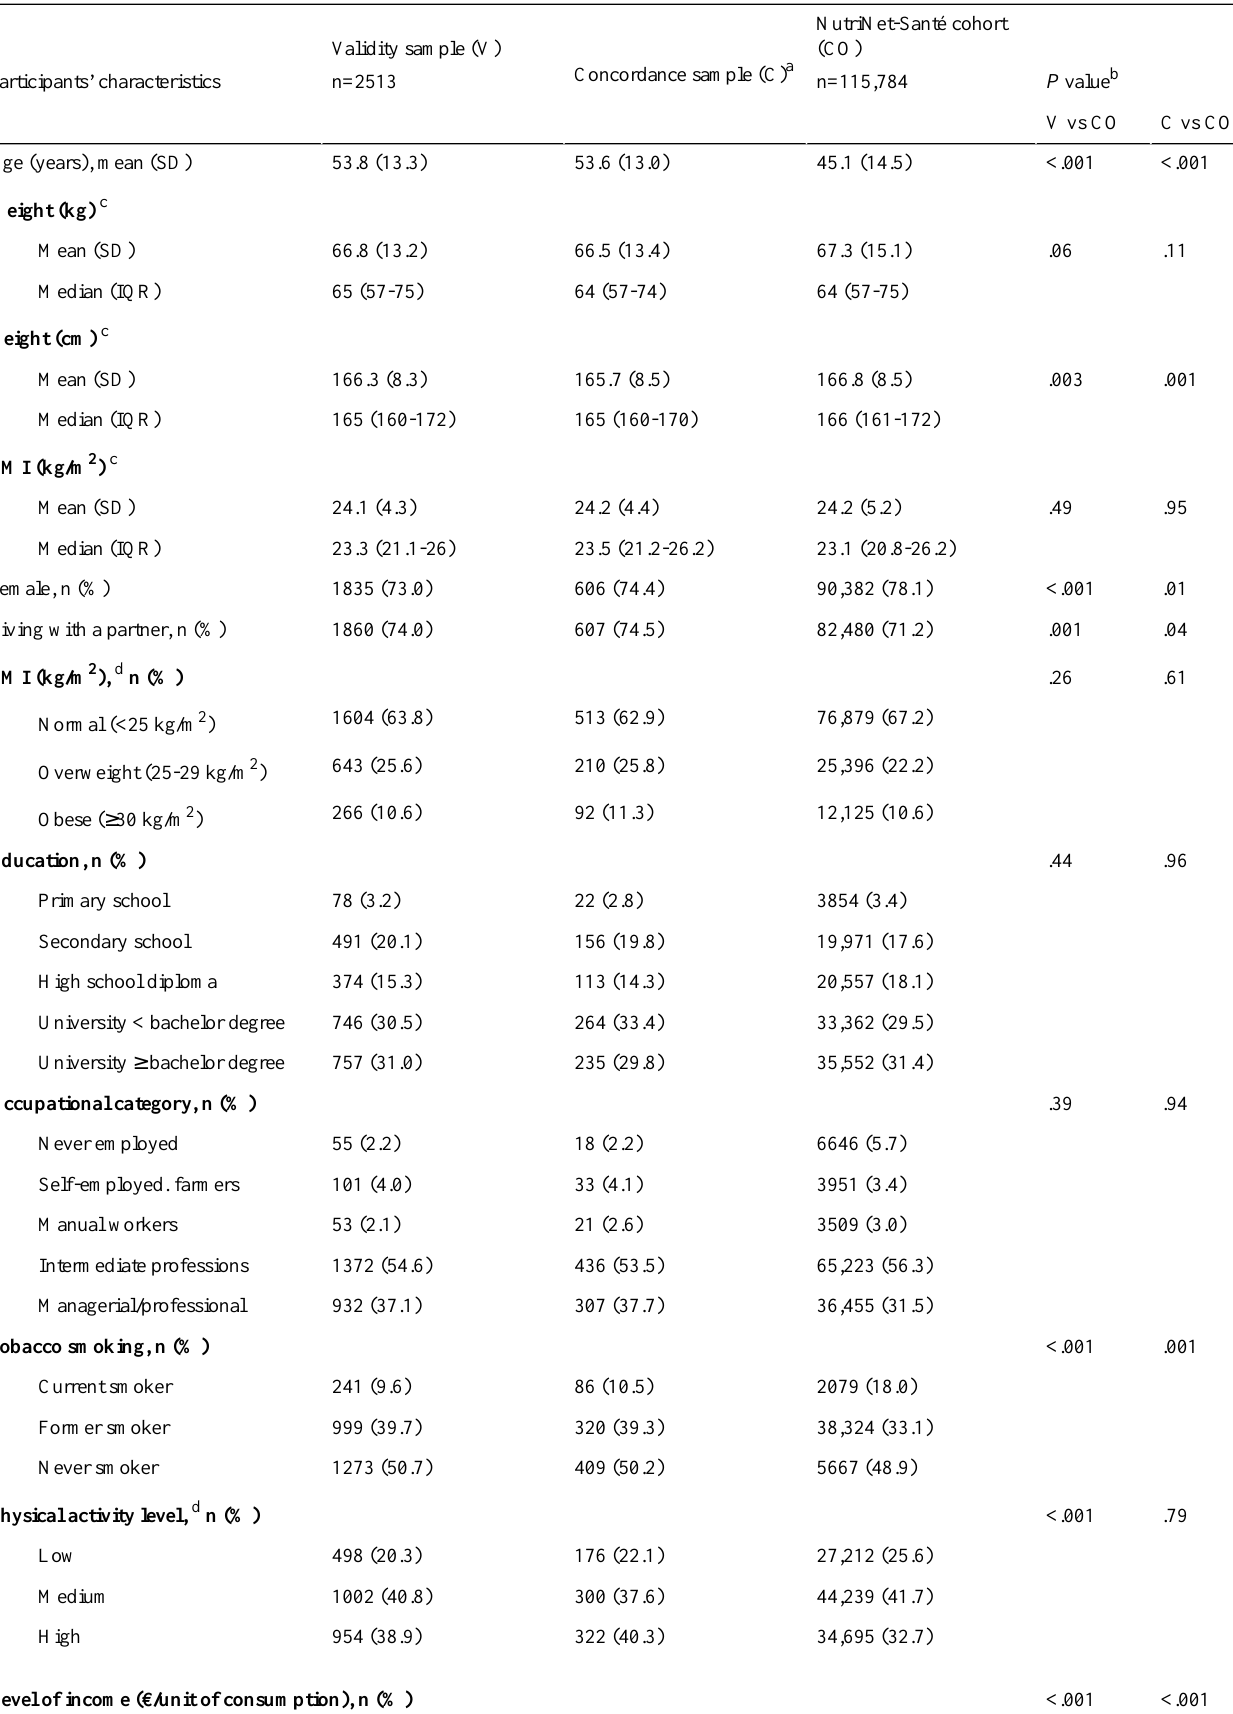
Table 1. Characteristics of the validation study sample (N=2513) and the concordance study sample (n=815) from the NutriNet-Santé Study, 2012,